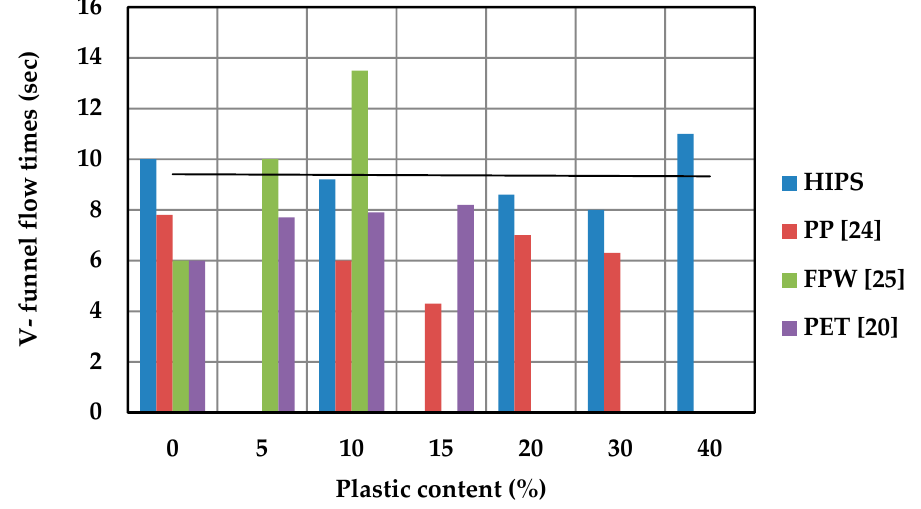
Figure 5. V-funnel flow time variation with different % of plastic Figure 5. V- funnel flow time variation with different % of plastic content . 219